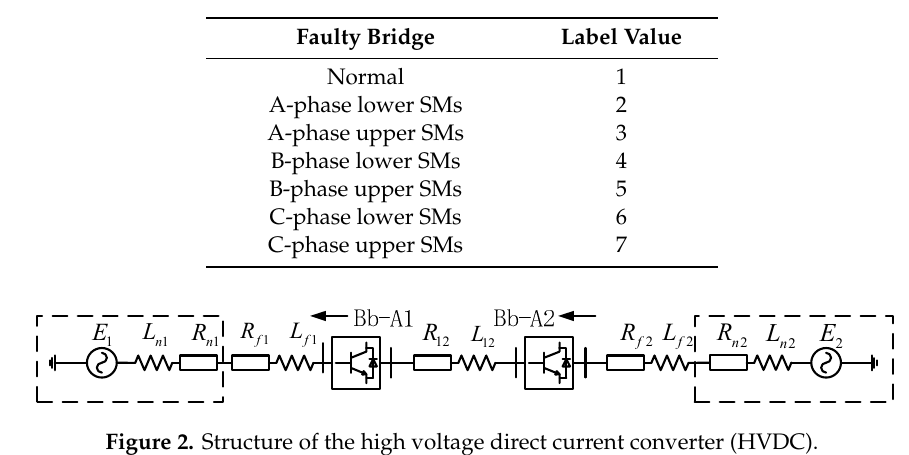
Figure 2. Structure of the high voltage direct current converter (HVDC)